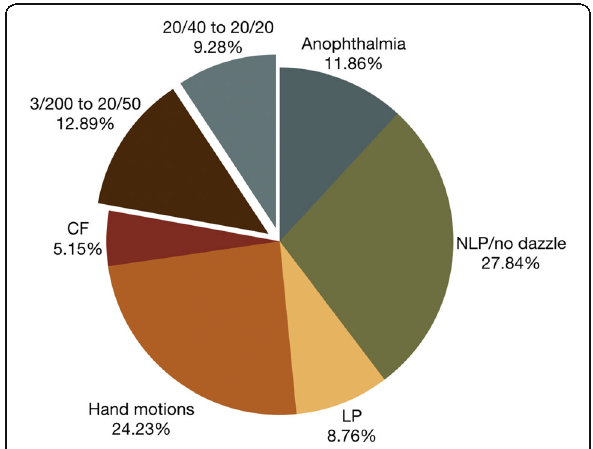
Fig. 5 Final best corrected visual acuities of patients at discharge ( n = 194), exluding eight pre-verbal children with vision better than NLP or no dazzle. Forty percent of patients either lost the globe or lost all vision. Only 22% of patients were left with useful vision. NLP=no